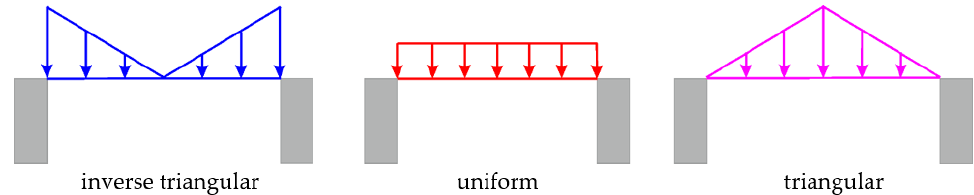
Figure 1. Distributions of the equivalent load modelling the load of the LTP reinforcement.